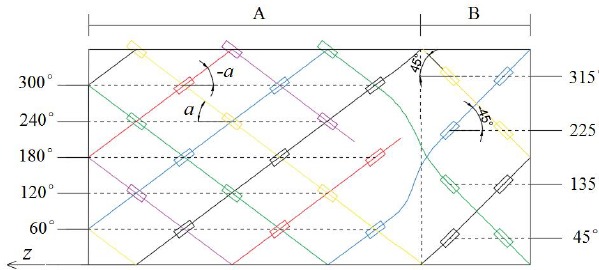
Figure 5. The layout position of the sensor group.